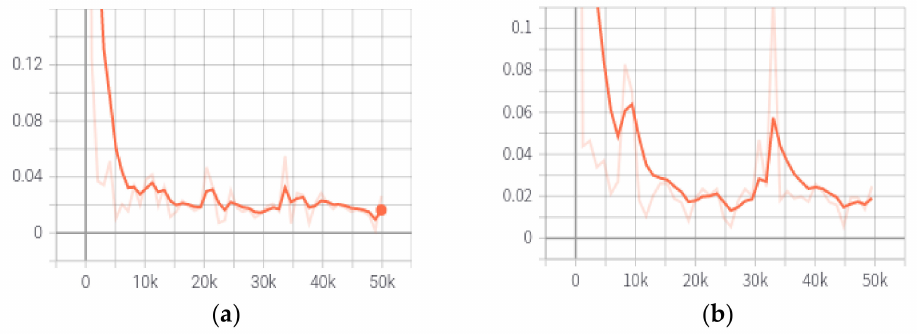
Figure 8. The training and validation loss curve of the Dense-DeepLabv3+. ( a ) training loss curve ( b ) validation loss curve.